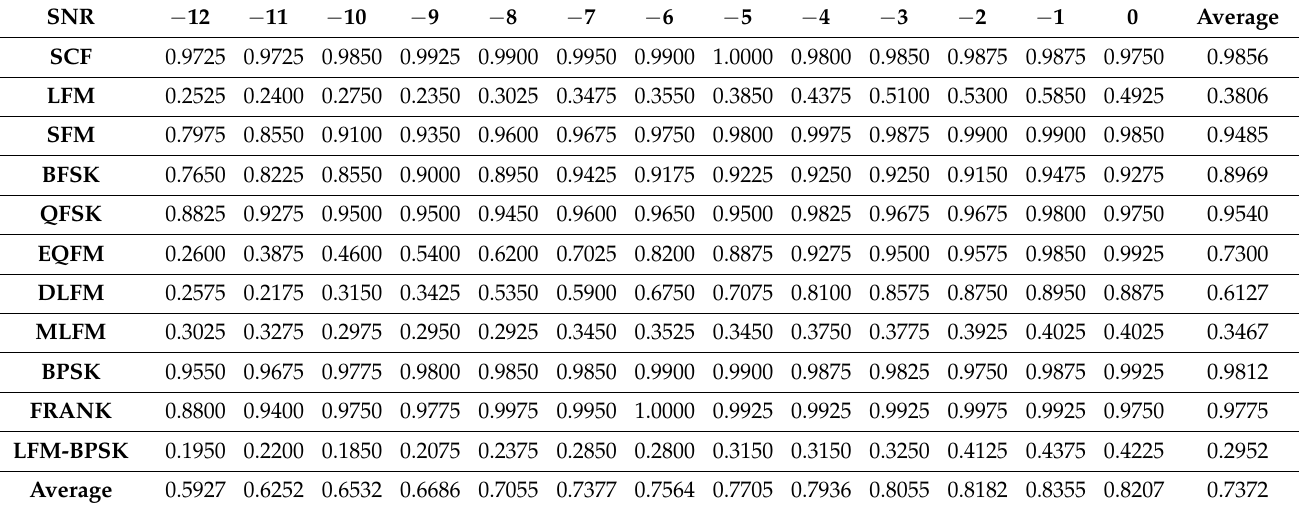
Table A26. The fully supervised classification results with the datasets in Situation Dataset 1.